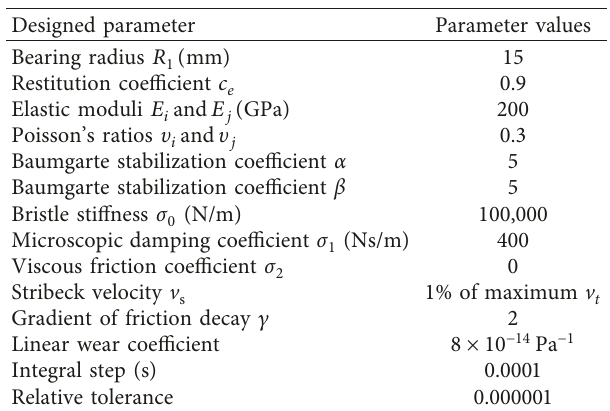
Table 2: Clearance joints’ parameters.